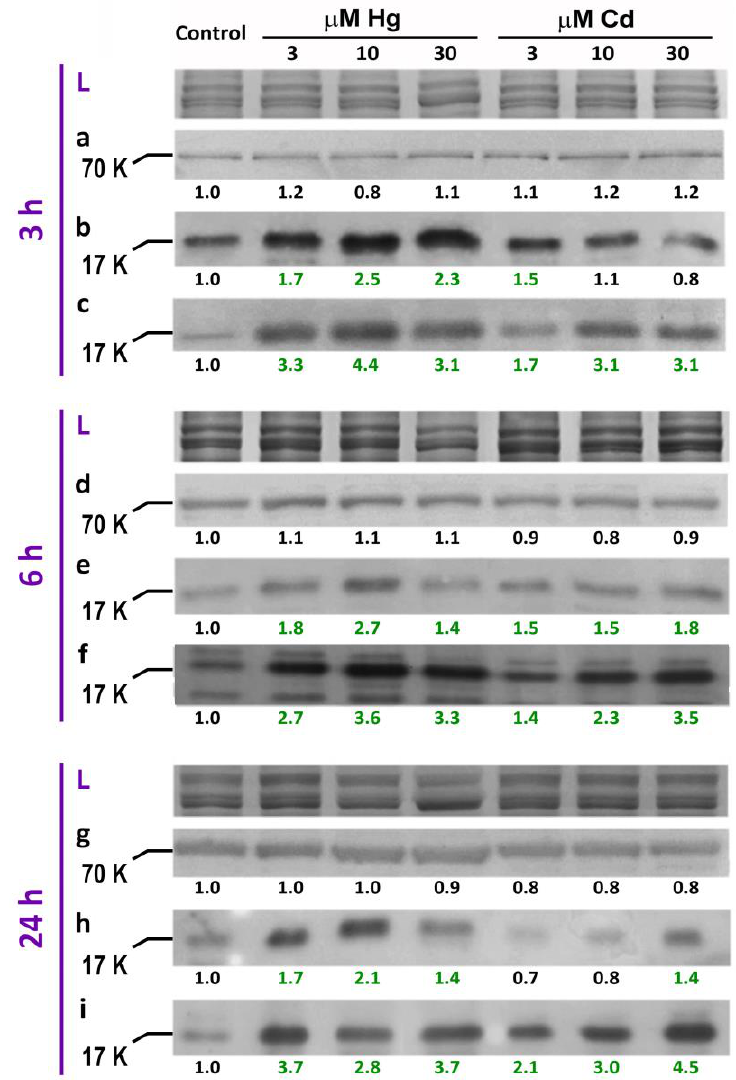
Figure 2. Induction of small Heat Shock Proteins (sHSPs) in roots of Medicago sativa seedlings treated with Hg or Cd (0, 3, 10, and 30 µM) for 3, 6 and 24 h in the microscale hydroponic system, detected by immunostaining: α -HSP70 ( a , d , g ), α -sHSP17.7 Class II ( b , e , h ), and α -sHSP17.6 Class I ( c , f , i ), with apparent molecular (K; KDa) weight of bands of interest. Band intensity was normalised against Coomassie blue general protein staining after denaturing PAGE, corresponding to L (protein loading) bands. The numbers show the fold change relative to control samples, and green coloured figures represent fold-changes above 30%.